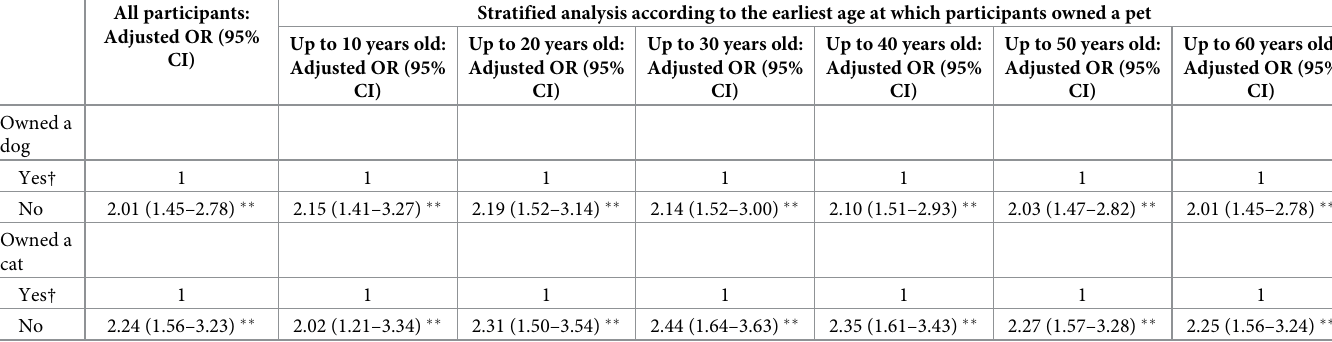
Table 2. Independent associations of dog and/or cat ownership with the onset of asthma in Japanese from birth to old age. All participants: Adjusted OR